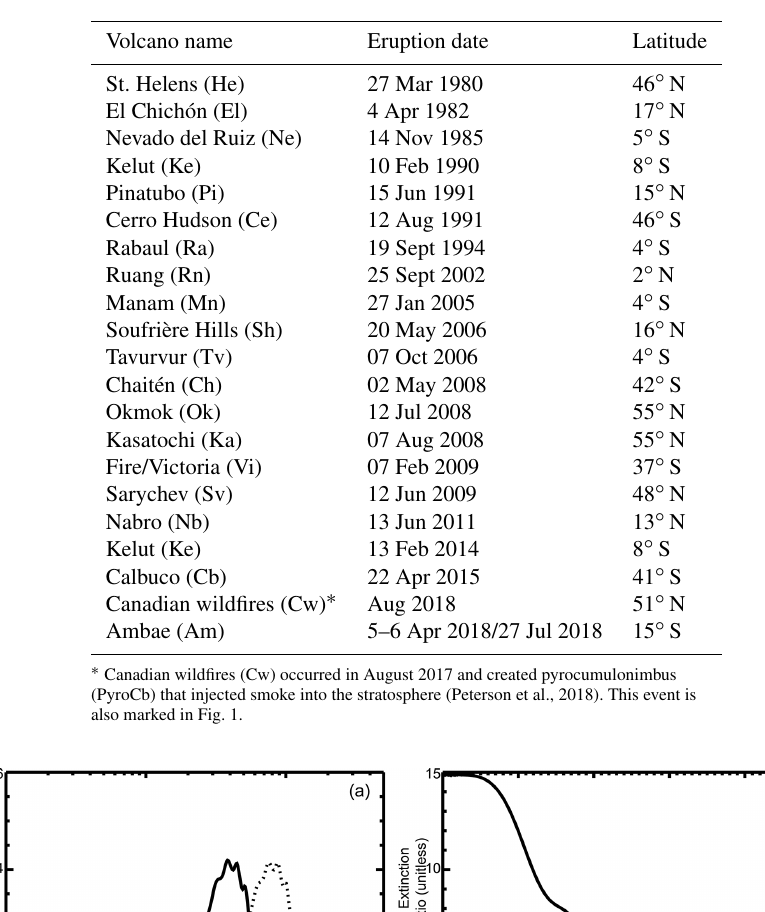
Table 1. Volcanic eruptions and smoke events that significantly impact stratospheric aerosol levels in Version 2.0 of the GloSSAC data set (Kovilakam et al., 2020); these events are denoted in Fig. 1 using the abbreviations in parentheses following their names.